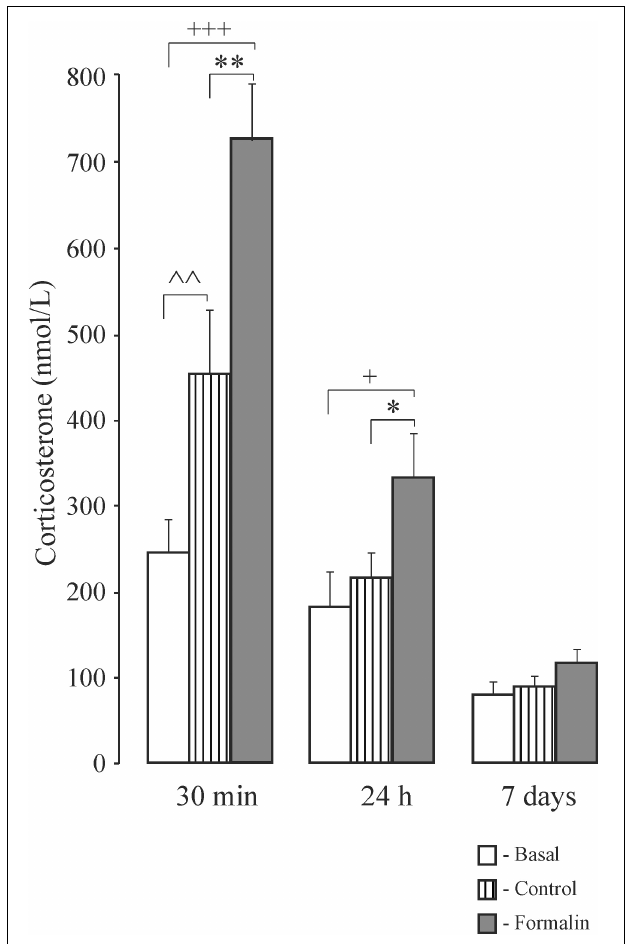
FIGURE 6 | Mean ( ± SEM) corticosterone levels in blood plasma in neonatal pups under basal conditions, or 30 min, 24 h and 7 days after injection of Formalin (2.5%, 0.5 µ l) or Control into the pad of the left hind paw. ∗ p < 0.05, ∗∗ p < 0.01, Formalin vs saline; + p < 0.05, +++ p < 0.001, Formalin vs basal; ∧∧ p < 0.01, saline vs